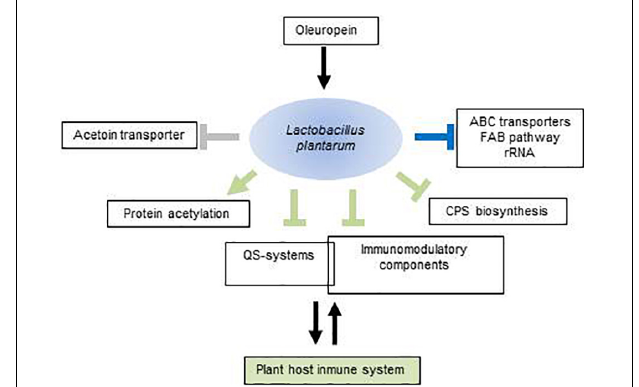
FIGURE 4 | Schematic view of molecular components potentially involved in the Lactobacillus plantarum –plant host interaction that are modulated by oleuropein. Arrows represent upregulated components; perpendicular bars, downregulated components. In green, functions with potential to exert selective pressures on the plant immune system; in blue, functions mediating adaptation to oleuropein; in gray, functions affecting the effectiveness of plant developmental signals. Intersection of rectangles indicates that some QS-components act as immunomodulators. For more details, see text. FAB, fatty acid biosynthesis; QS, quorum sensing; CPS,